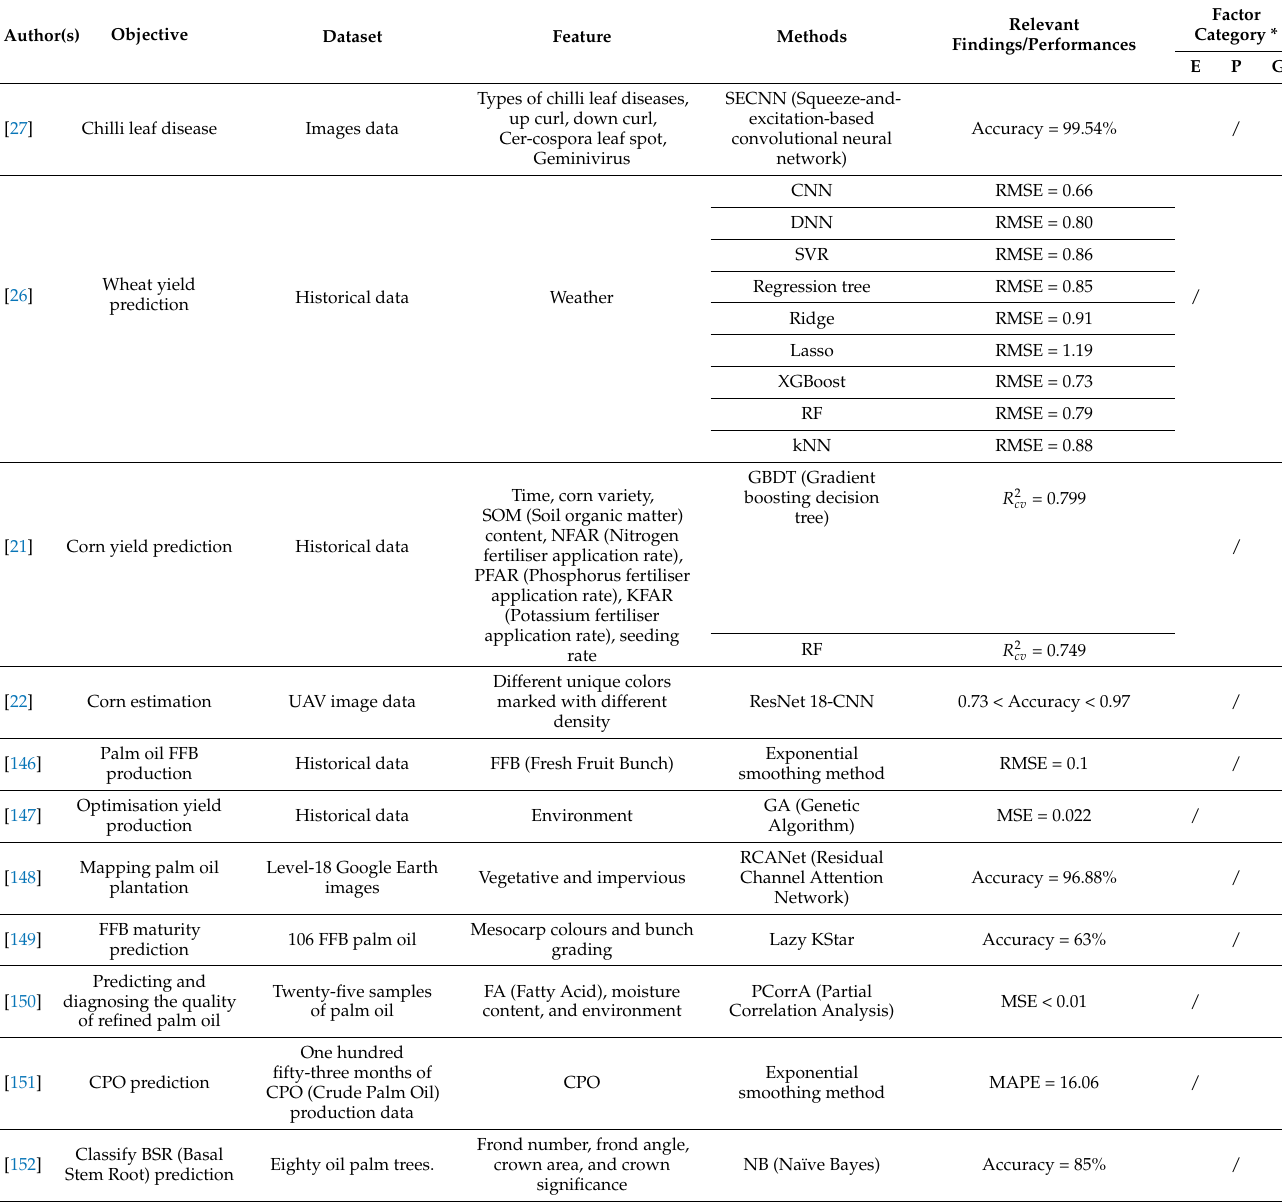
Table 9. Other approaches’ predictions of crops and palm